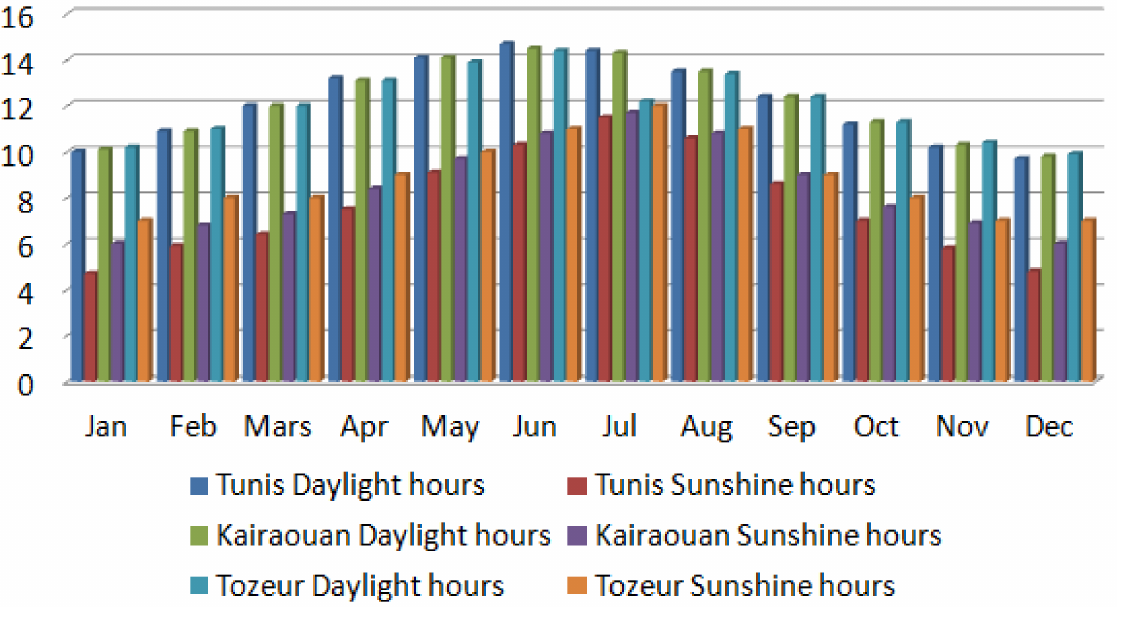
Figure 8. Average daylight and